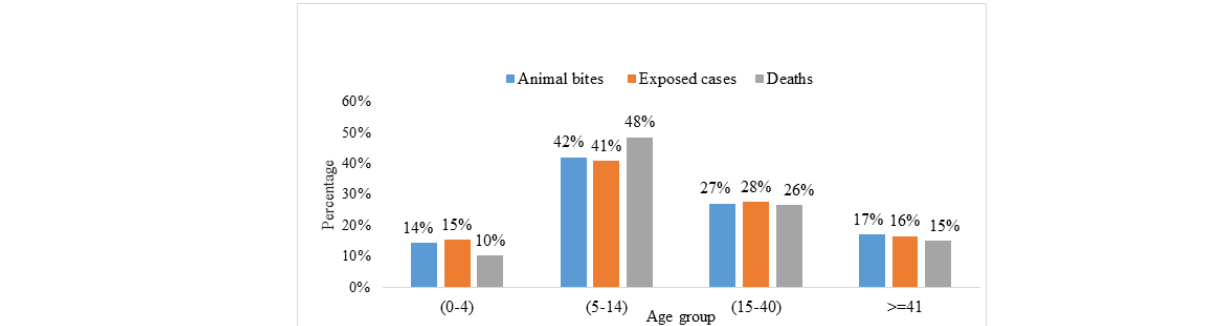
Figure 1. Distribution of animal bites cases, exposed cases, and rabies deaths by age groups in Yemen between 2011 and 2017.